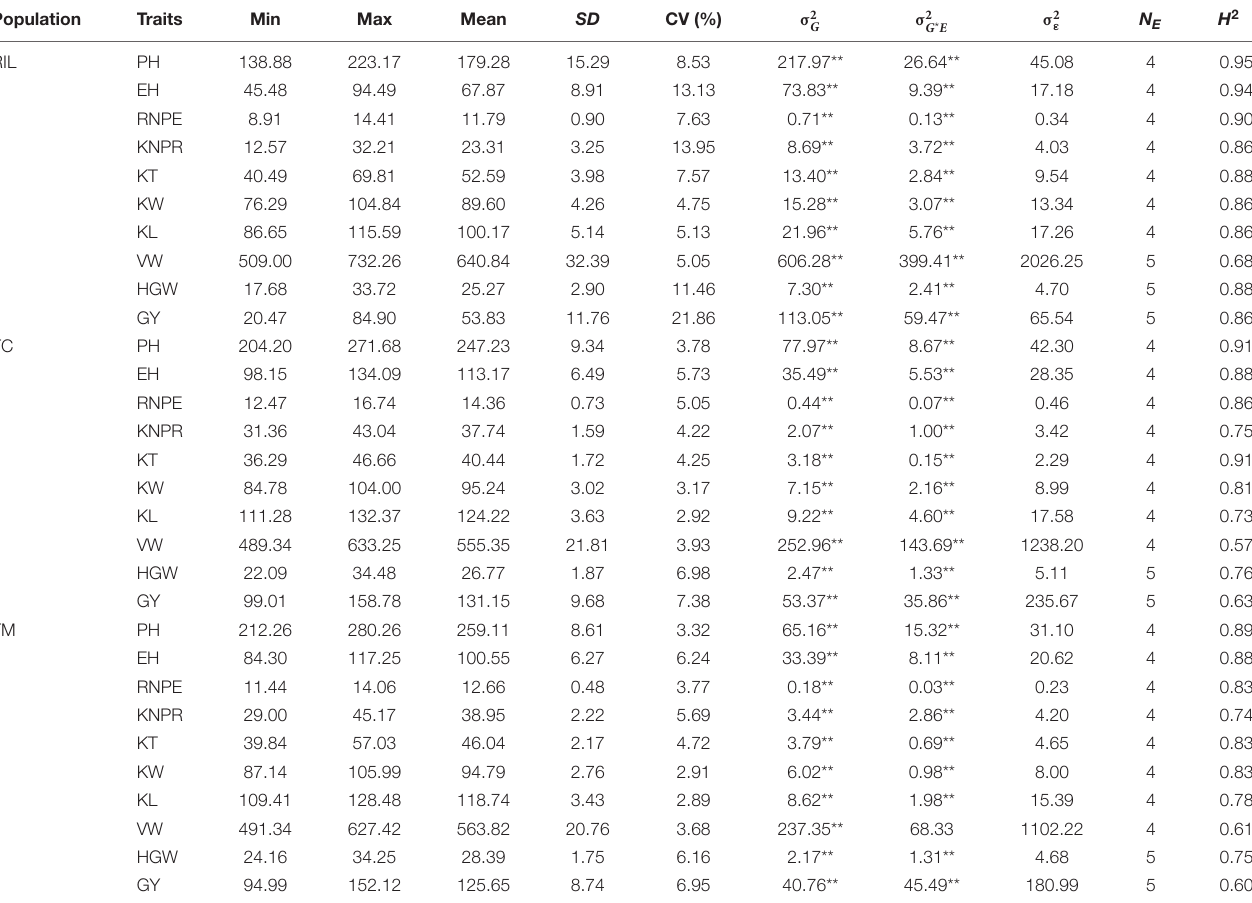
TABLE 1 | Summary statistics for 10 traits in the recombinant inbred line population developed by Ye478 × Qi319 (RIL), Chang7-2 × RIL (TC), and Mo17 × RIL (TM) populations. Population